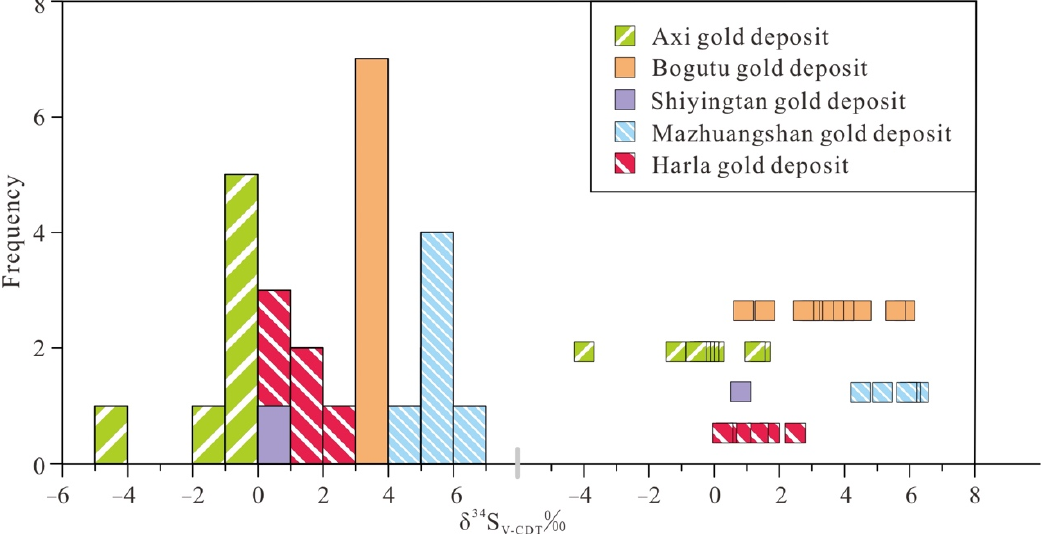
Figure 10. δ 34 S values for pyrite in the Harla gold deposit compared with other typical gold deposits. Data for other gold deposits are from Sun et al. [29], Zhai et al. [30], Wang et al. [32], and Li and Liu [34].